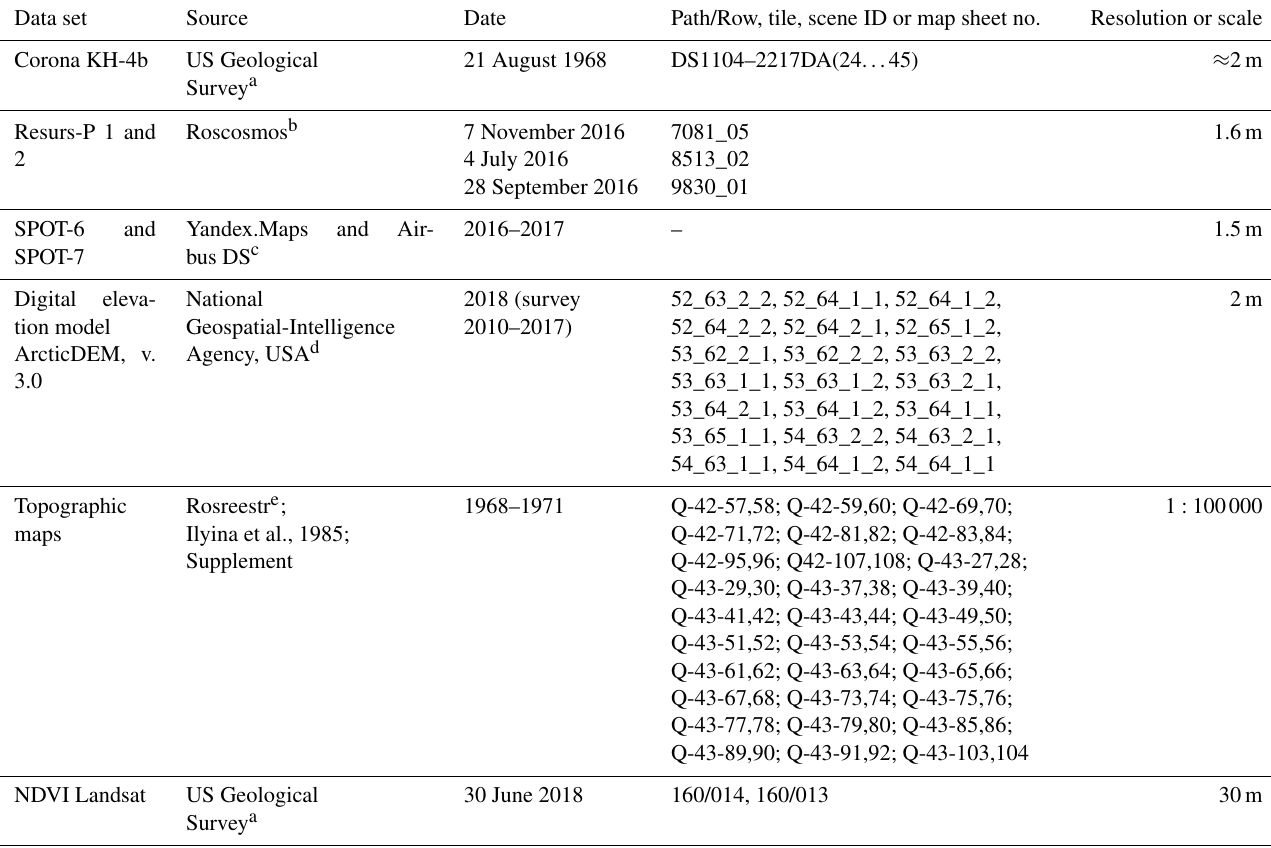
Table 5. Data sets used for the analysis of vegetation dynamics. Data set Source Path/Row, tile, scene ID or map sheet no.